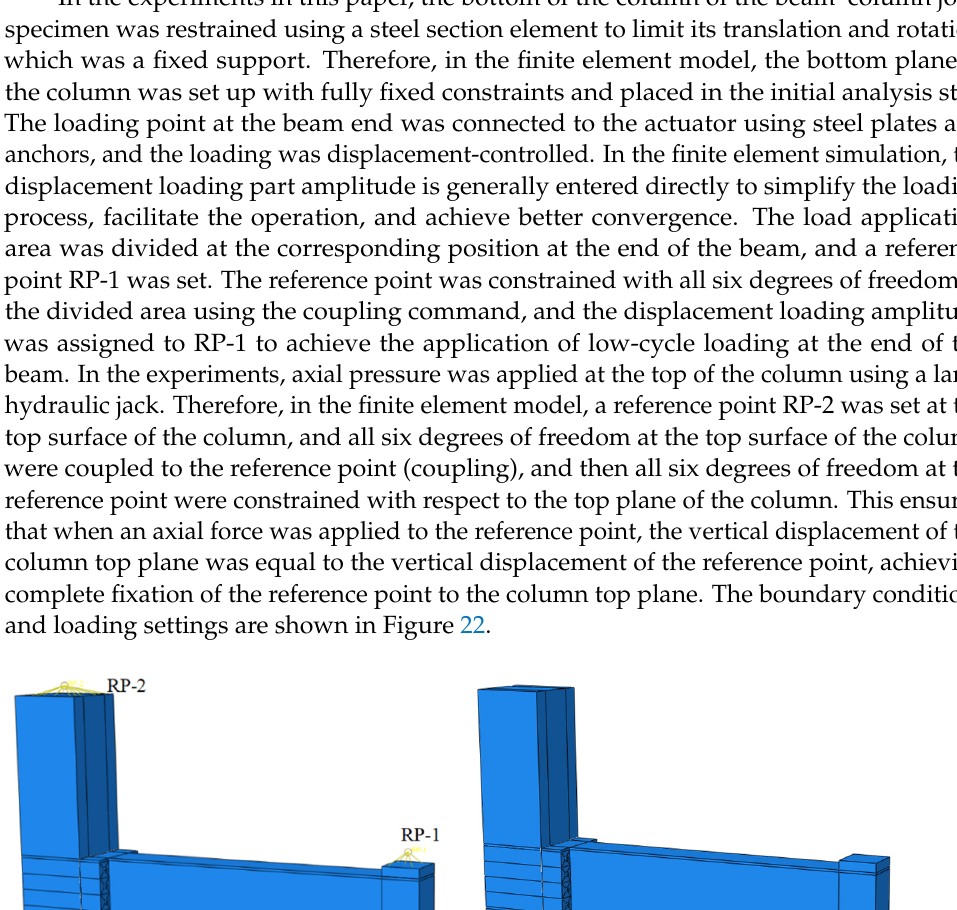
( b ) Figure 23. Comparison of experimental simulated load-displacement curves: ( a ) J1, ( b ) J2. F o r ce / k N